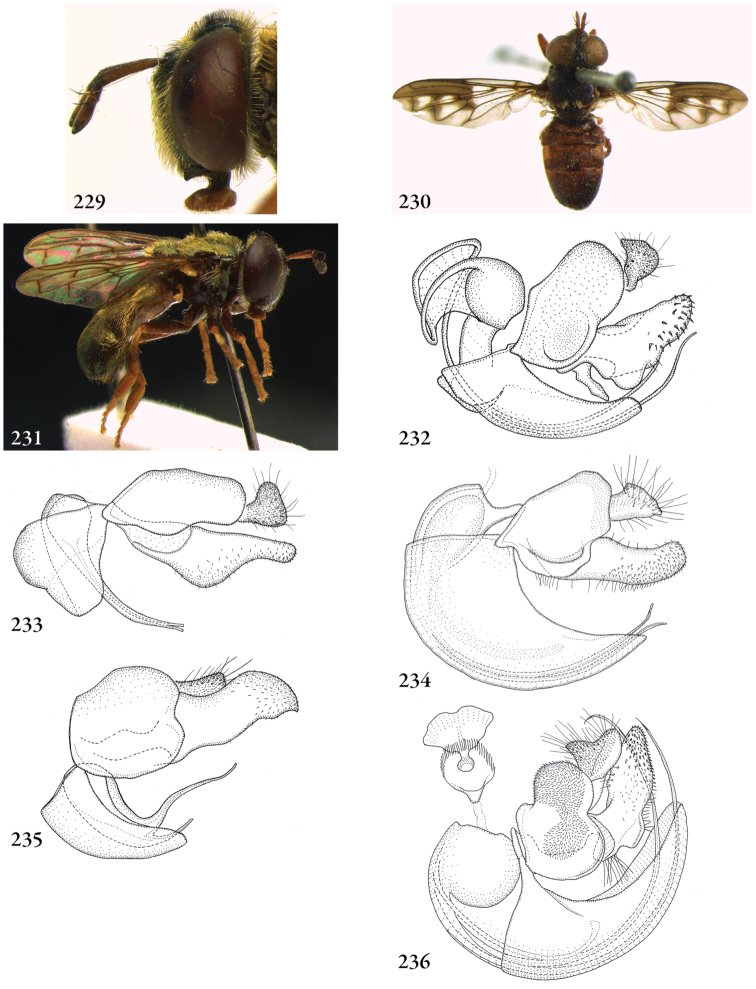
229
Microdon (virgo-group) rufiventris (Surinam, coll. RMNH), head lateral 230–231
Microdon (s.l.), male, habitus: 230
Microdon pictipennis (Australia, coll. MNHN) 231
Microdon tsara (holotype) 232–236
Microdon (s.l.), male genitalia: 232
Microdon craigheadi (USA, Georgia, coll. RMNH) 233
Microdon erythros (Congo, coll. RMNH) 234
Microdon bertonii (Brazil, coll. RMNH) 235
Microdon tarsalis (holotype) 236
Microdon rufiventris (Surinam, coll. RMNH).